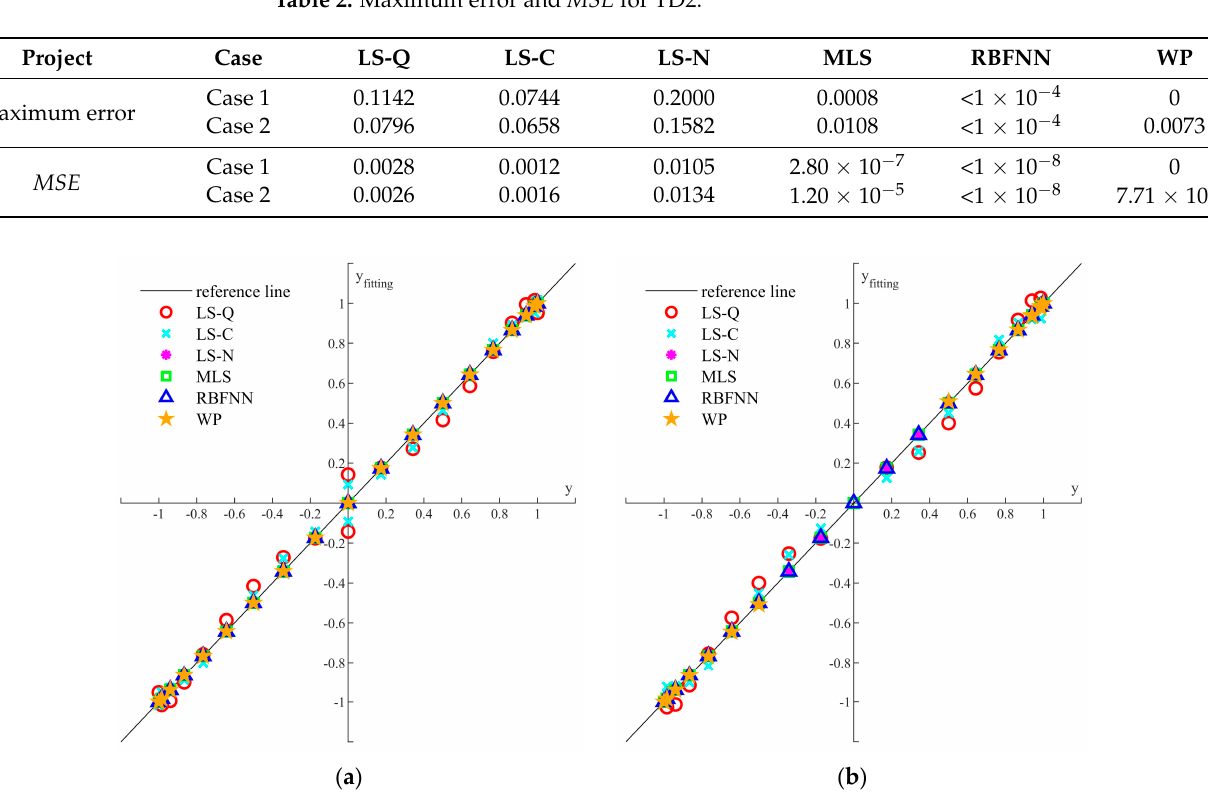
Table 4. Maximum error and MSE for TD4.